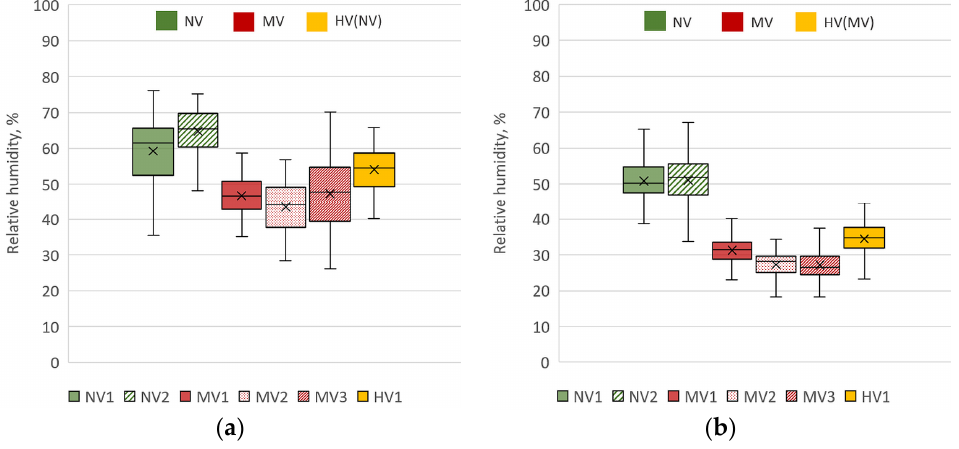
Figure 4. Bedroom relative humidity, hours 11 pm–7 am: ( a ) summer–autumn; ( b ) winter.